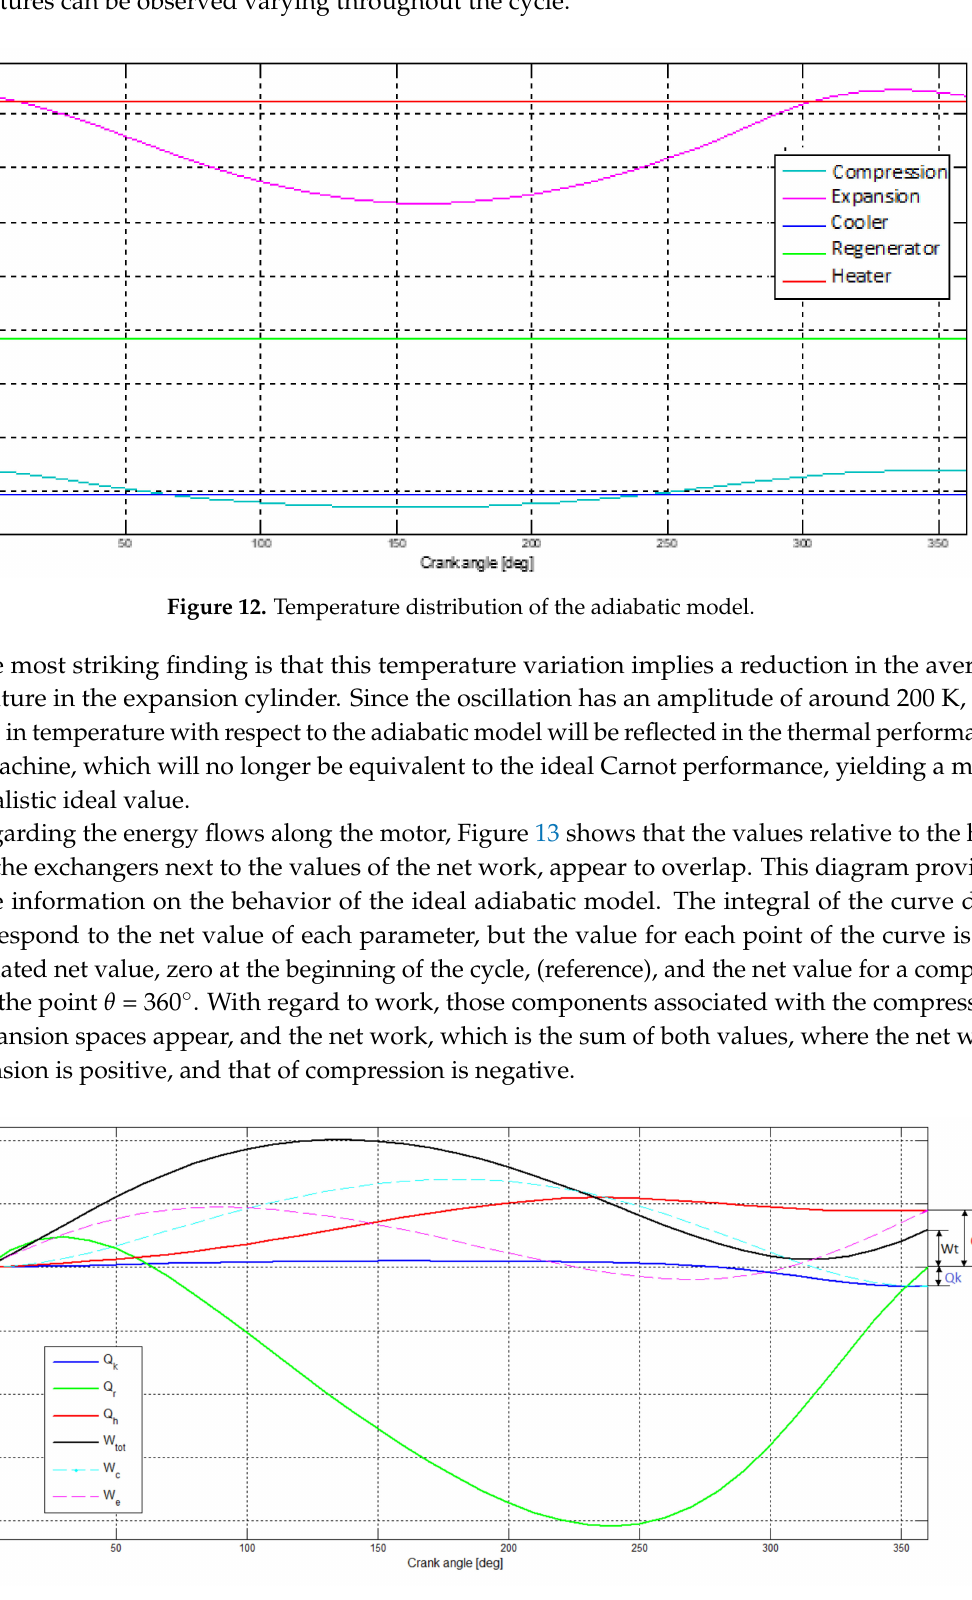
Figure 13. Distribution of net energy flows of the adiabatic